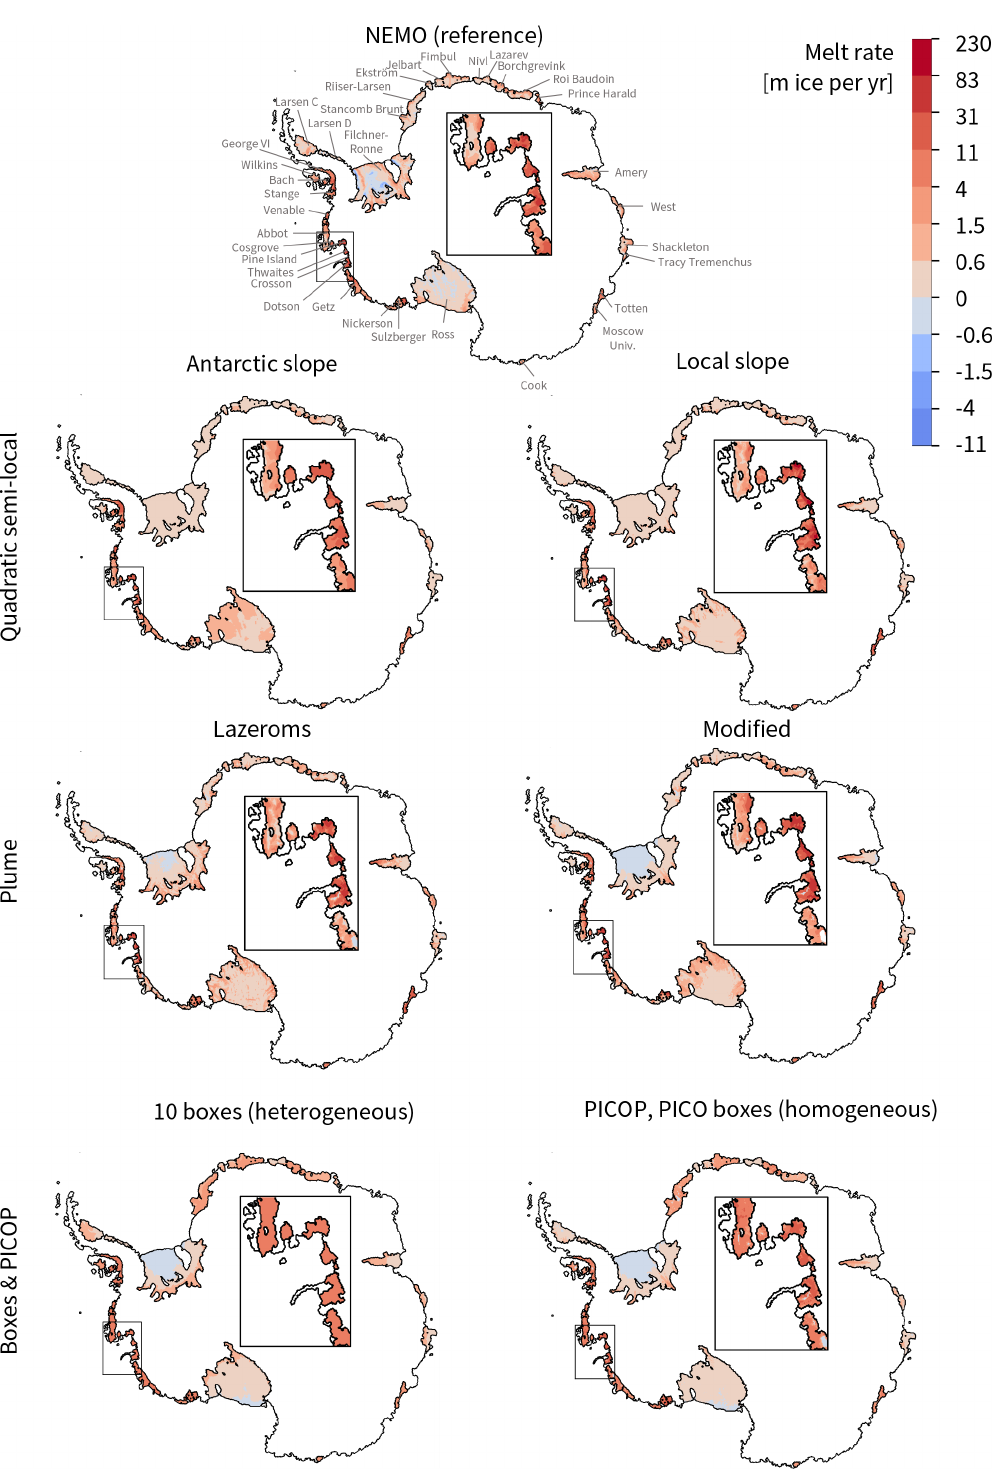
Figure 5. Spatial distribution of the yearly mean sub-shelf melt rates for a subset of the tuned parameterisations and for the reference for comparison. The parameterised melt rates are computed using the best-estimate parameters given in Tables 4, 6, 8, and 10. This is the time average for the REALISTIC run (39 years). Note that the land tongue in the Amundsen Sea was introduced to mimic the effect of grounded icebergs present in that region on the sea-ice circulation (see Sect.